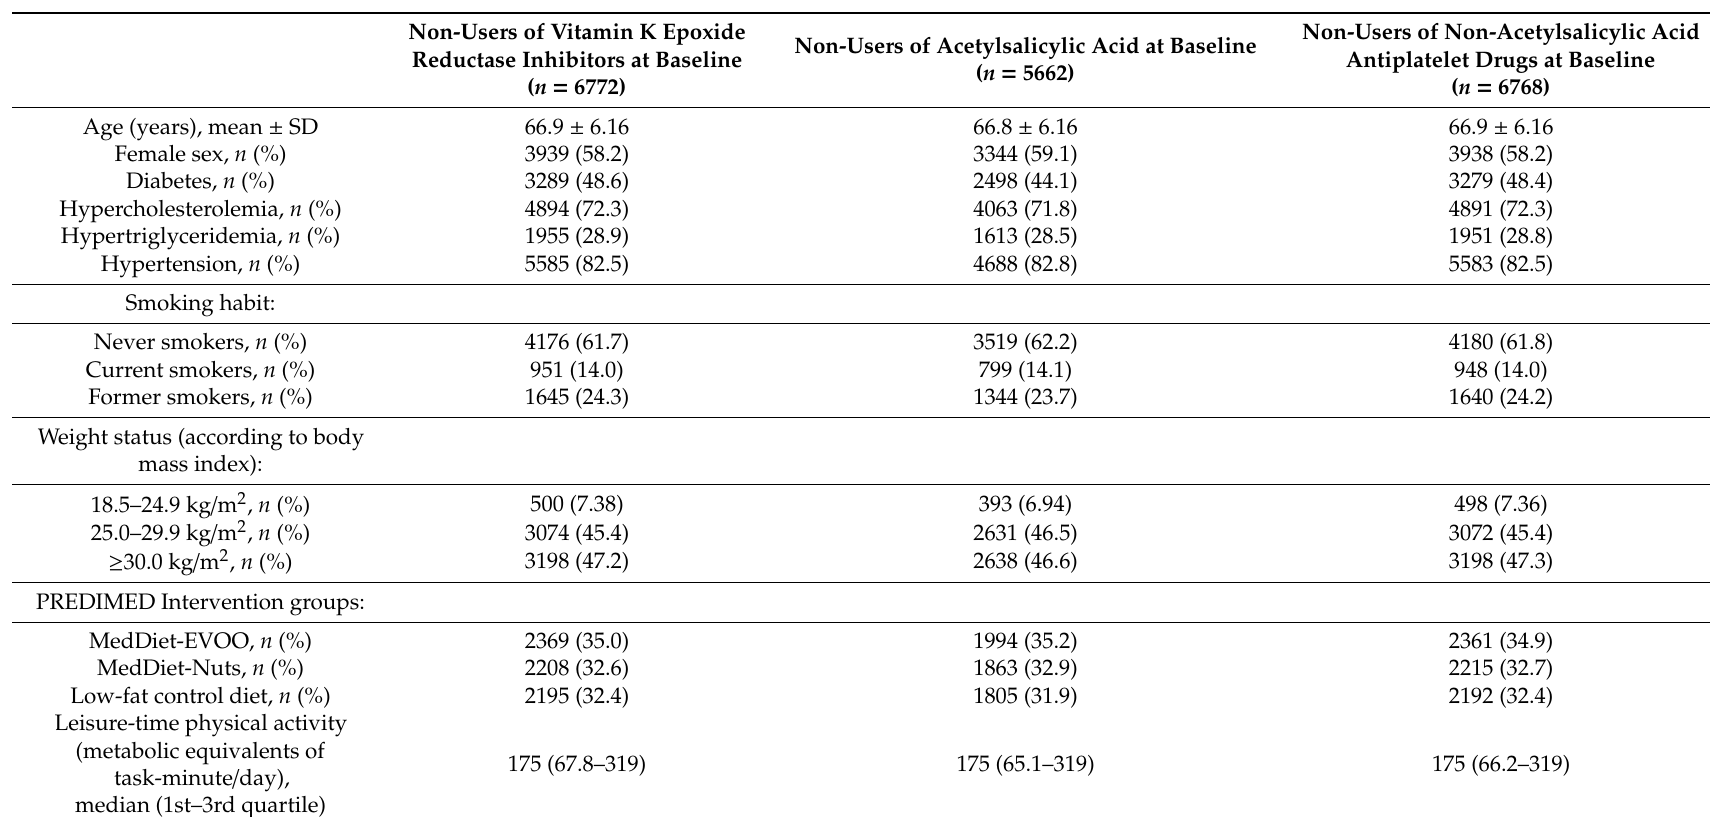
Table 1. Study population